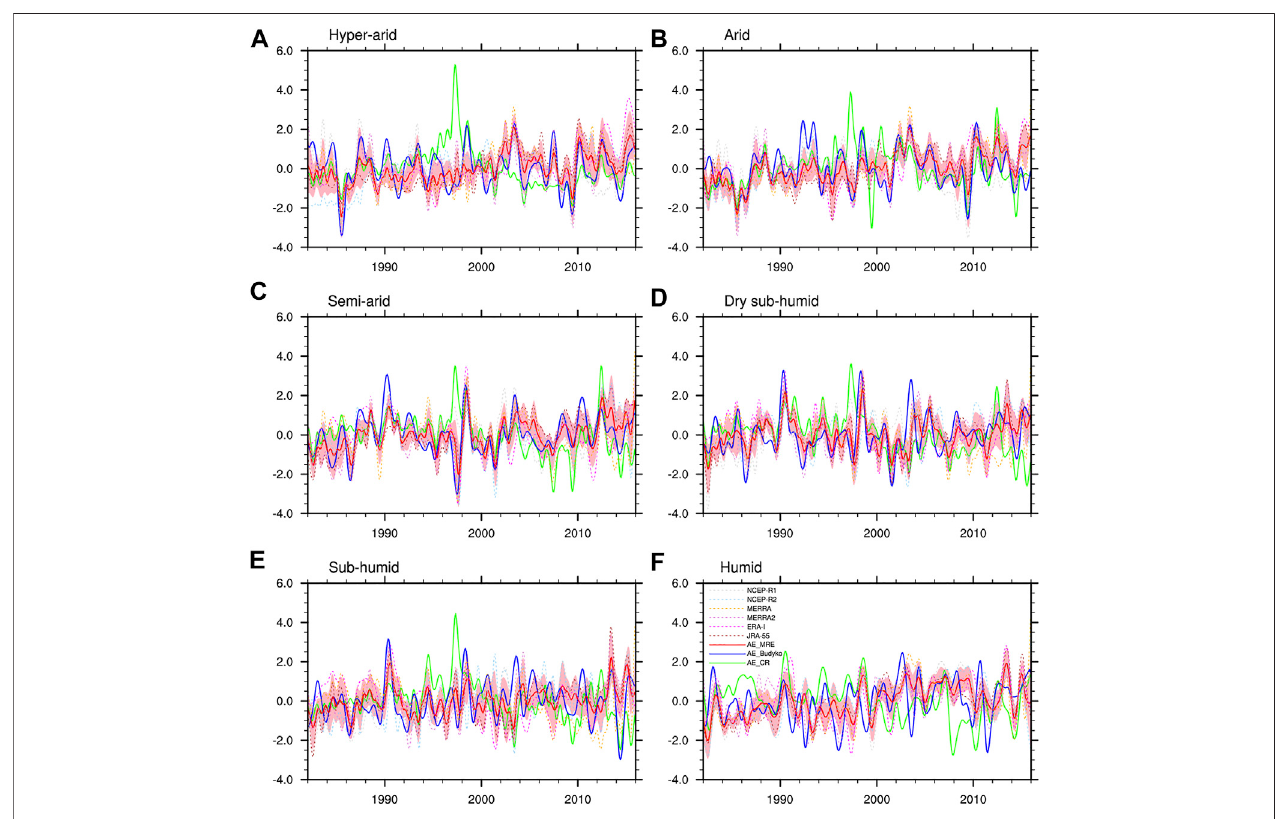
FIGURE 3 | X-12-ARIMA trend components ( T t ) of actual evapotranspiration (AE) derived from AE_WAR, AE_CR, AE_Budyko, and reanalyses over the (A) hyper- arid, (B) arid, (C) semi-arid, (D) dry sub-humid, (E) sub-humid, and (F) humid regions.